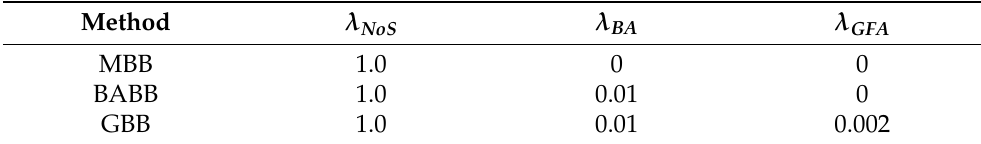
Table 2. Loss weights configuration for three